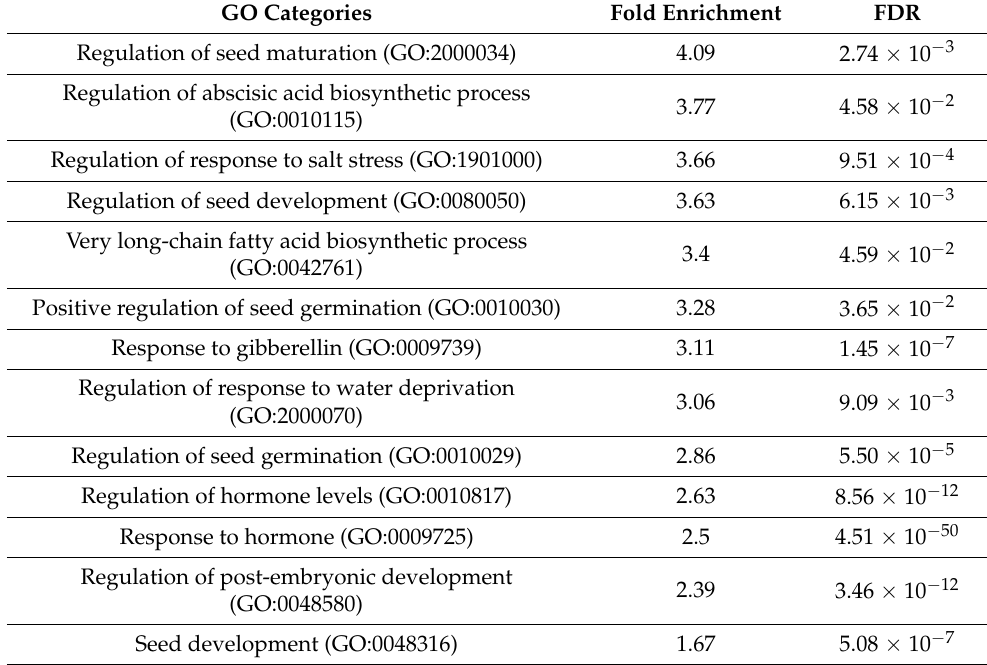
Table 1. GO categories for genes with AGL15 ChIP-Seq binding sites. The GO identification number is in parentheses. This GO analysis includes all 5454 genes associated with AGL15 as found by ChIP- Seq. Fold enrichment indicates how overrepresented genes the genes are in a category compared to the whole genome. FDR; false discovery